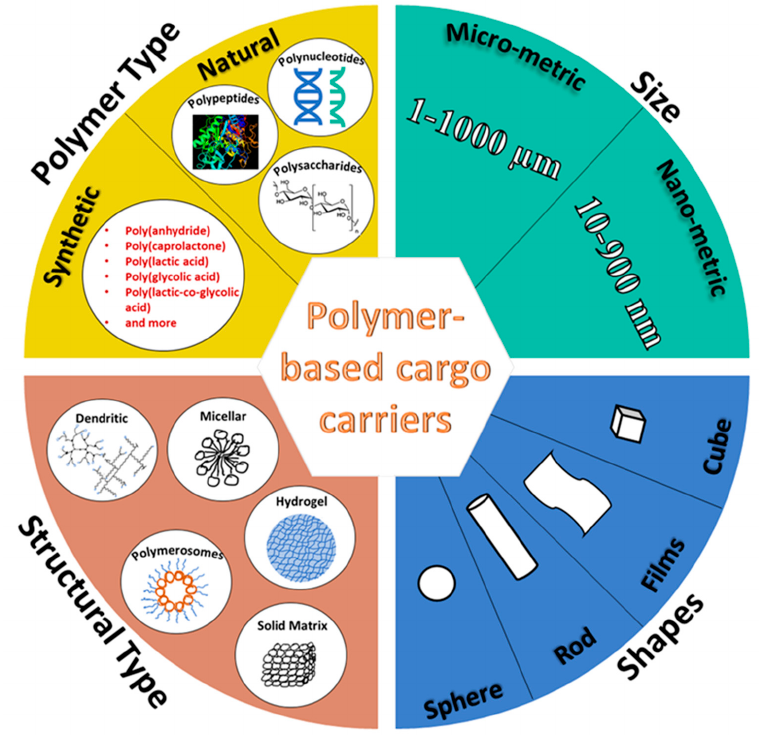
Figure 1. Classification of polymer-based carriers of biomedical cargo. Table 1. List of natural polymers utilized to develop biomedical carriers .